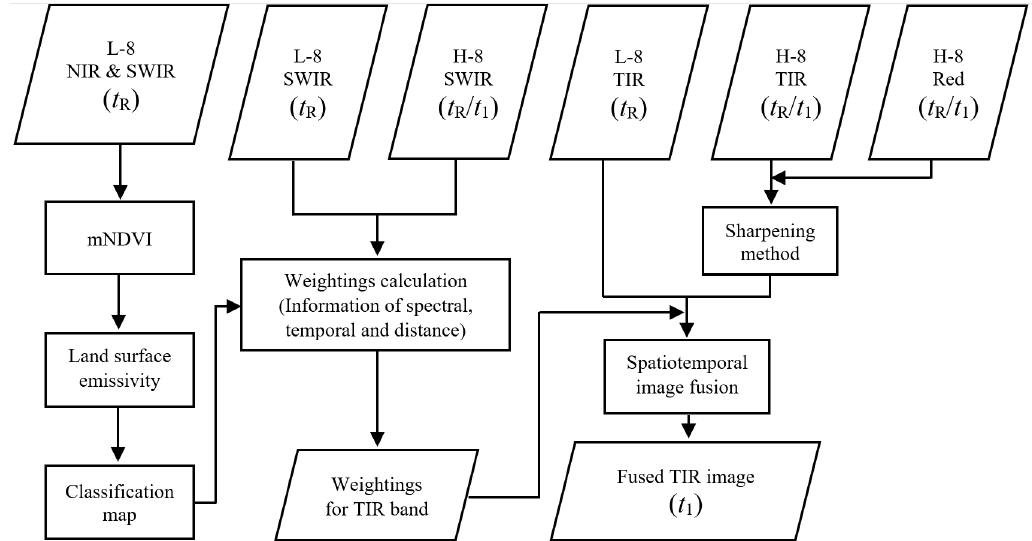
Figure 2. Flowchart of STAEFM approach. NIR, near infrared; SWIR, shortwave infrared; TIR, thermal infrared; mNDVI, modified normalized difference vegetation index.